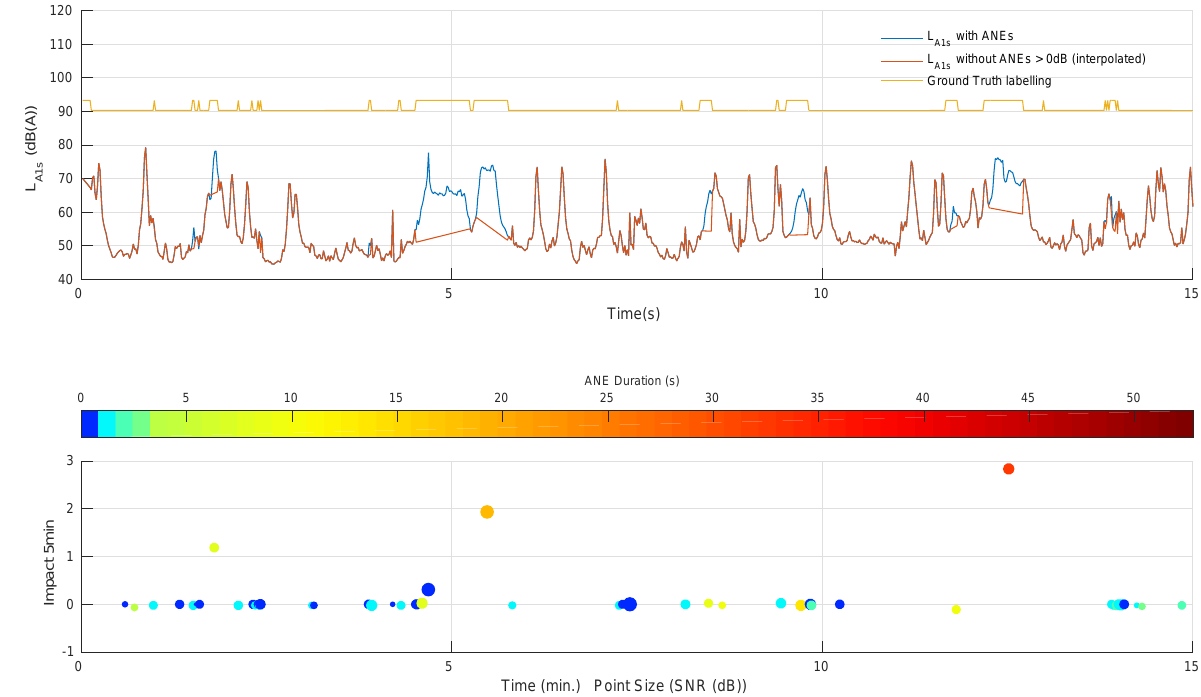
Figure 6: A detailed example of the Site 4 of the Milan pilot area recording [43], showing the bias of the ANEs on the L A 300 s computation, including the evolution of the L curve with and without ANEs obtained from the ground truth manual labelling reference. A 1 s